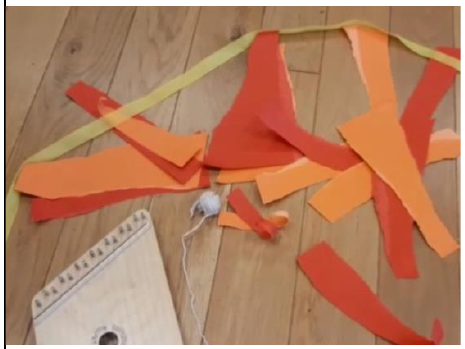
Figure 7. Ghosts of the past.